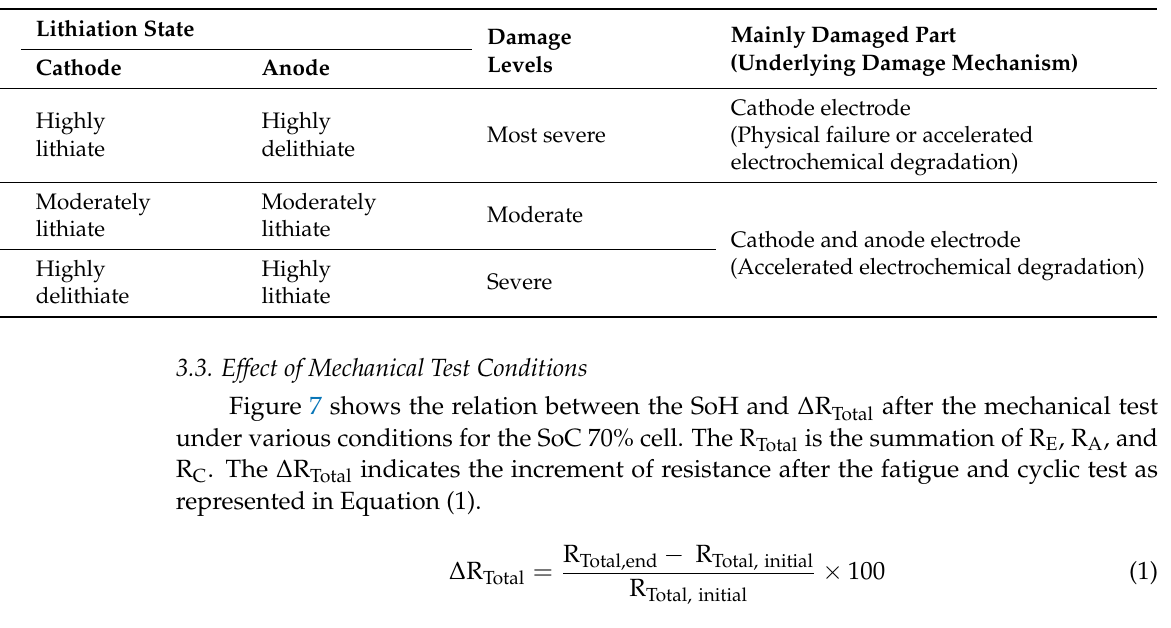
Table 2. Summarization on the effect of mechanical fatigue on the different SoC